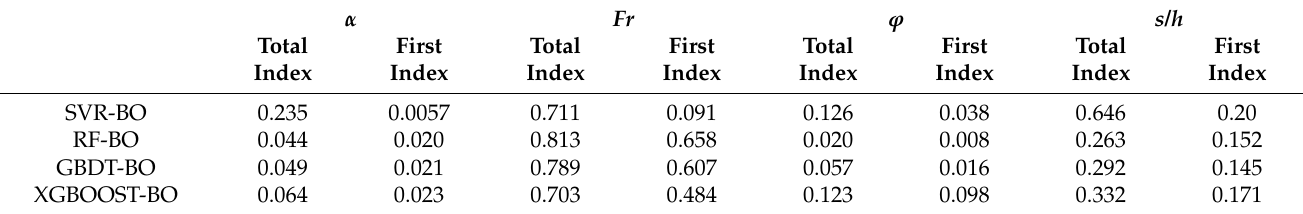
Table 6. First-order and total Sobol’s indices of Ml models with BO.